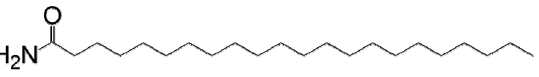
Figure 1. The structural formula of polyamide wax WTH-B.